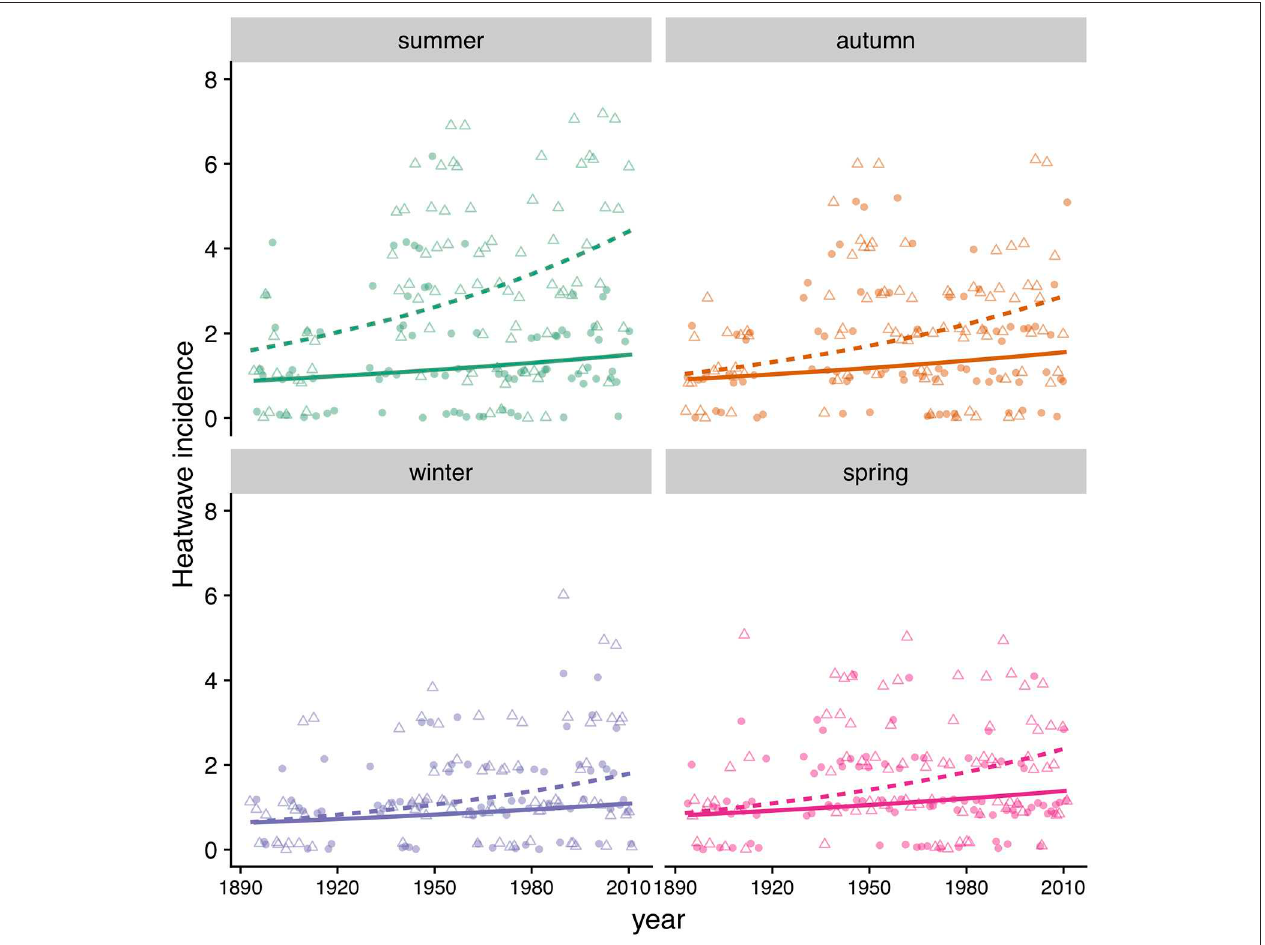
FIGURE 9 | Heatwave incidence (count) by season in MD (triangles, dashed line) and MA (circles, solid line). Symbols correspond to data points and lines to model predictions ( Table 4 ).